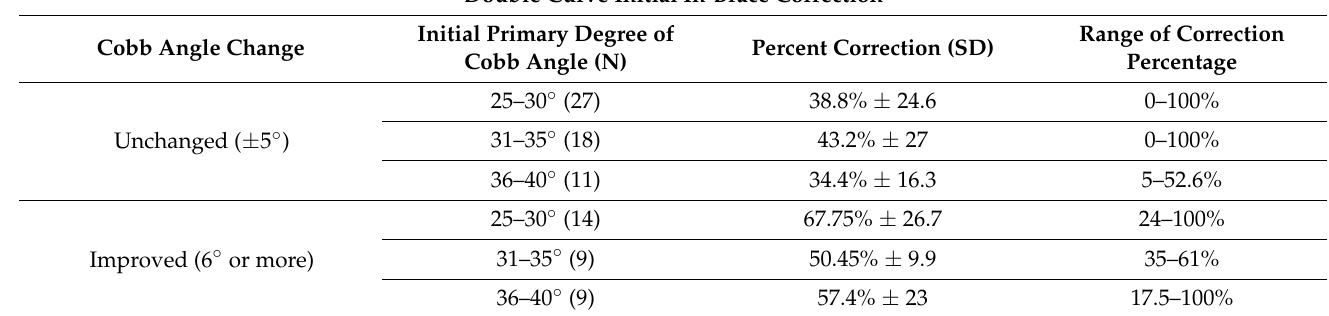
Table 7. Cont. Double Curve Initial In-Brace